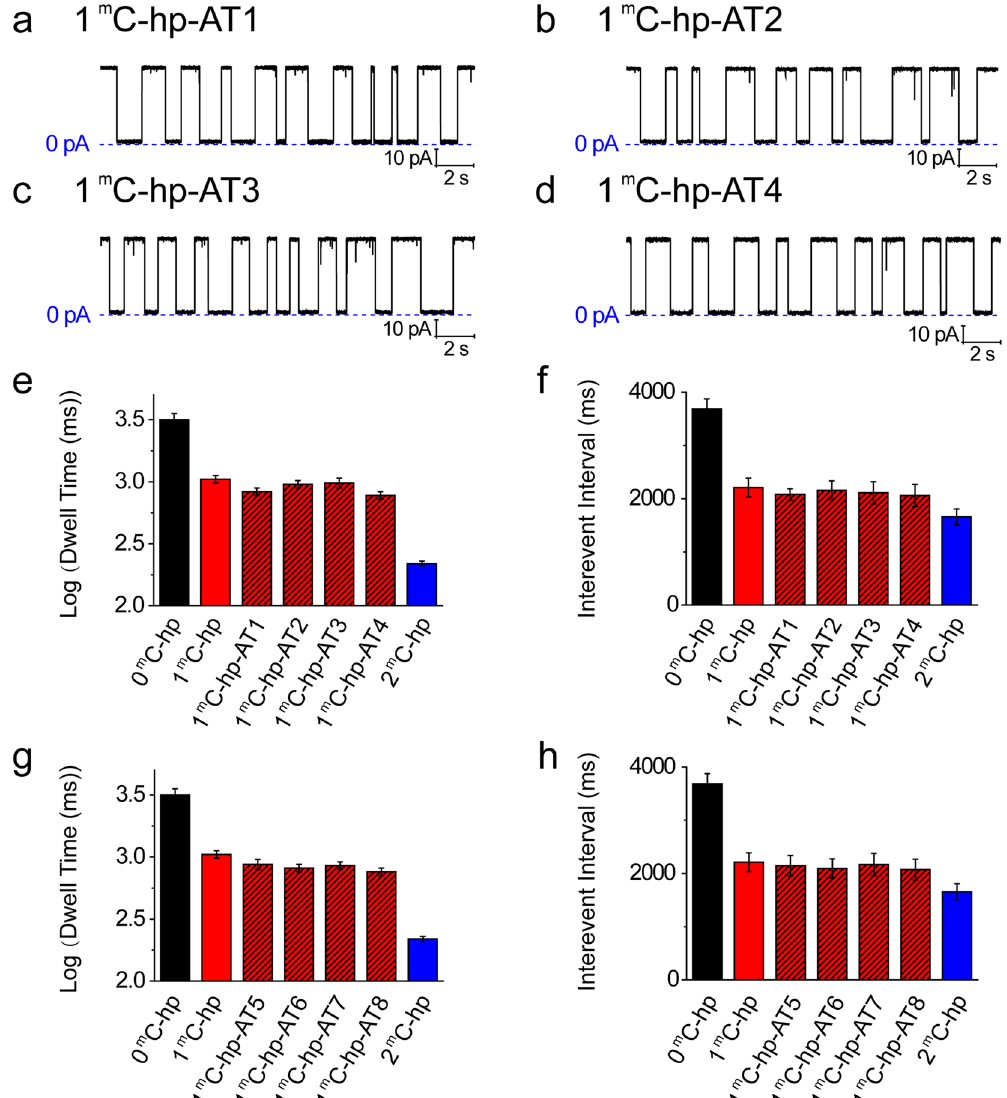
Figure 3. Effect of sequence context on distinguishing DNA methylation. ( a – d ) Current traces for 1 m C- hp-AT1 ( a ), 1 m C-hp-AT2 ( b ), 1 m C-hp-AT3 ( c ), and 1 m C-hp-AT4 ( d ) in 4 M TMA-Cl. ( e , f ) The peak value of dwell time (n = 4) in log-form histograms ( e ) and mean interevent interval (n = 4) of DNA hairpin translocation events ( f ) for 0 m C-hp, 1 m C-hp, 1 m C-hp-AT1, 1 m C-hp-AT2, 1 m C-hp-AT3, 1 m C-hp-AT4 and 2 m C-hp. ( g , h ) The peak values of dwell time (n = 4) values in log form ( g ) and mean interevent interval (n = 4) values ( h ) for replaced 1 m C-hps (1 m C-hp-AT5, 1 m C-hp-AT6, 1 m C-hp-AT7 and 1 m C-hp-AT8). The mean dwell times and mean interevent intervals were from single-channel recording, and signals were filtered at 2 kHz and sampled at 20 kHz. DNA (0.3 µ M) was added into the cis chamber. The buffer was 10 mM Tris-HCl (pH